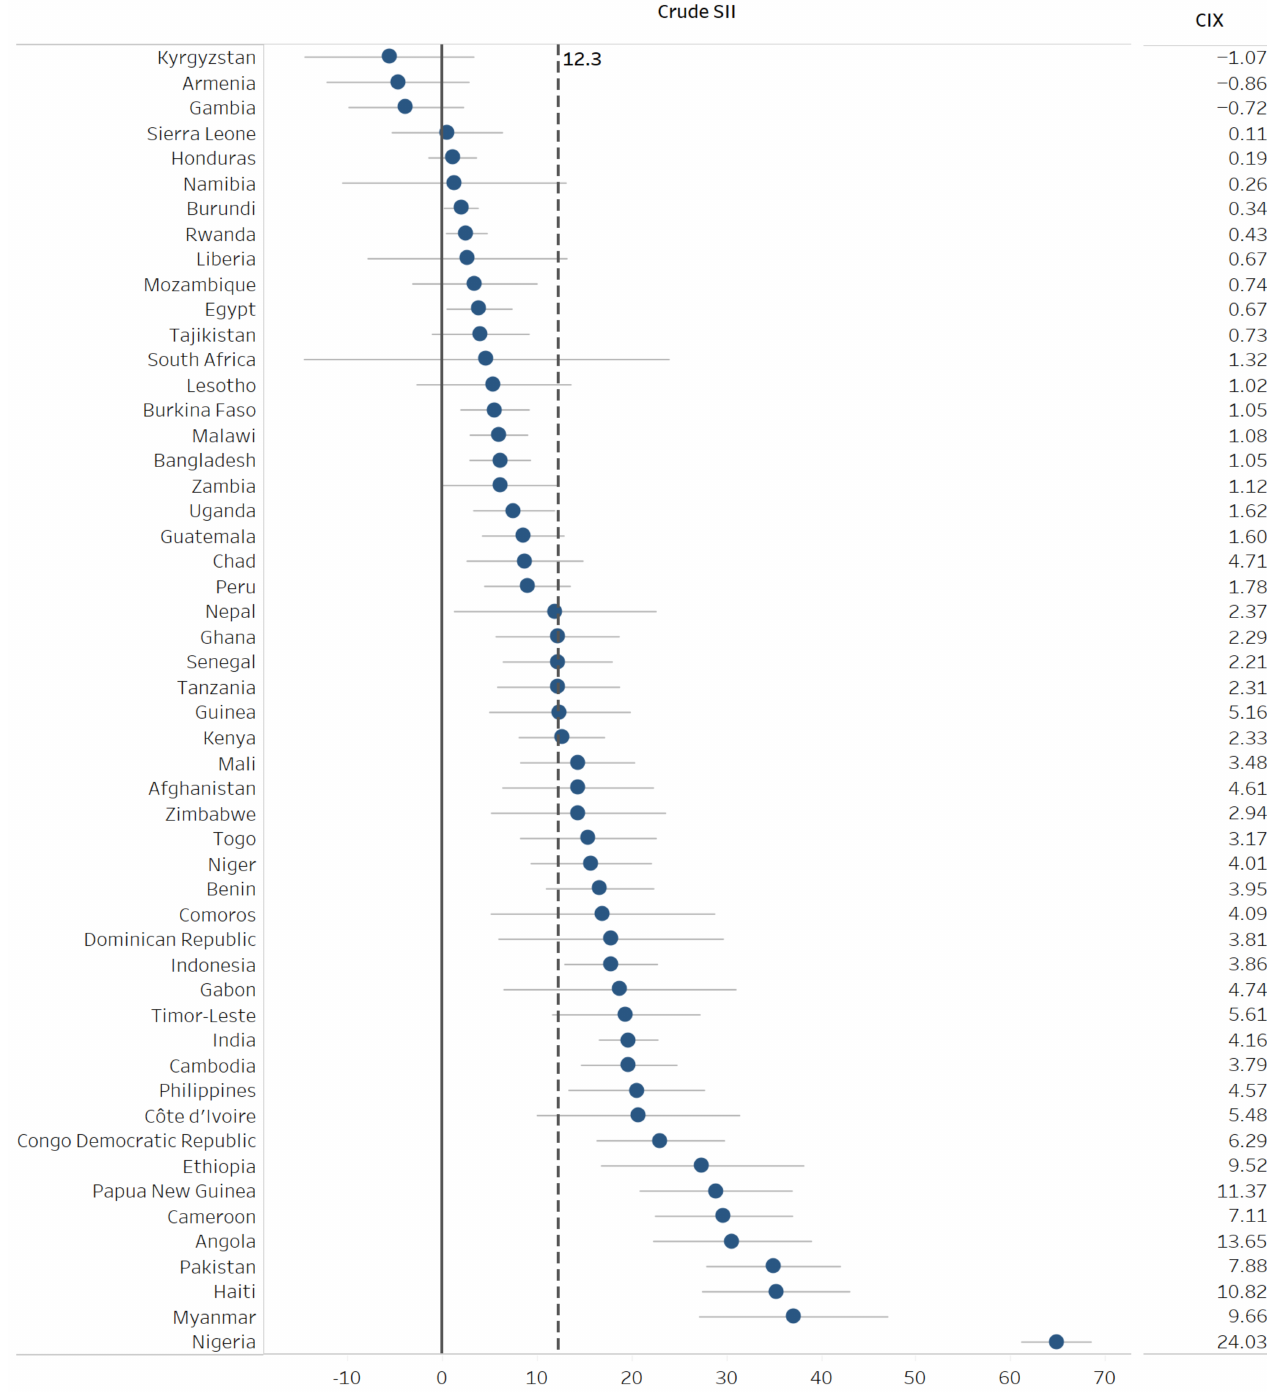
Figure 2. Inequality in DTP3 immunization coverage in women’s social independence in 52 countries: Crude Slope Index of Inequality and Concentration Index (DHS 2010–2019). Blue circles show the crude SII for each country. Horizontal grey lines indicate 95% confidence intervals for crude SII estimates. The black vertical dashed line indicates the median crude SII value across 52 countries. The black vertical solid line indicates the SII value of no inequality (zero). CIX = Concentration Index. DHS = Demographic and Health Surveys. DTP = diphtheria-tetanus-pertussis. SII = Slope Index of Inequality